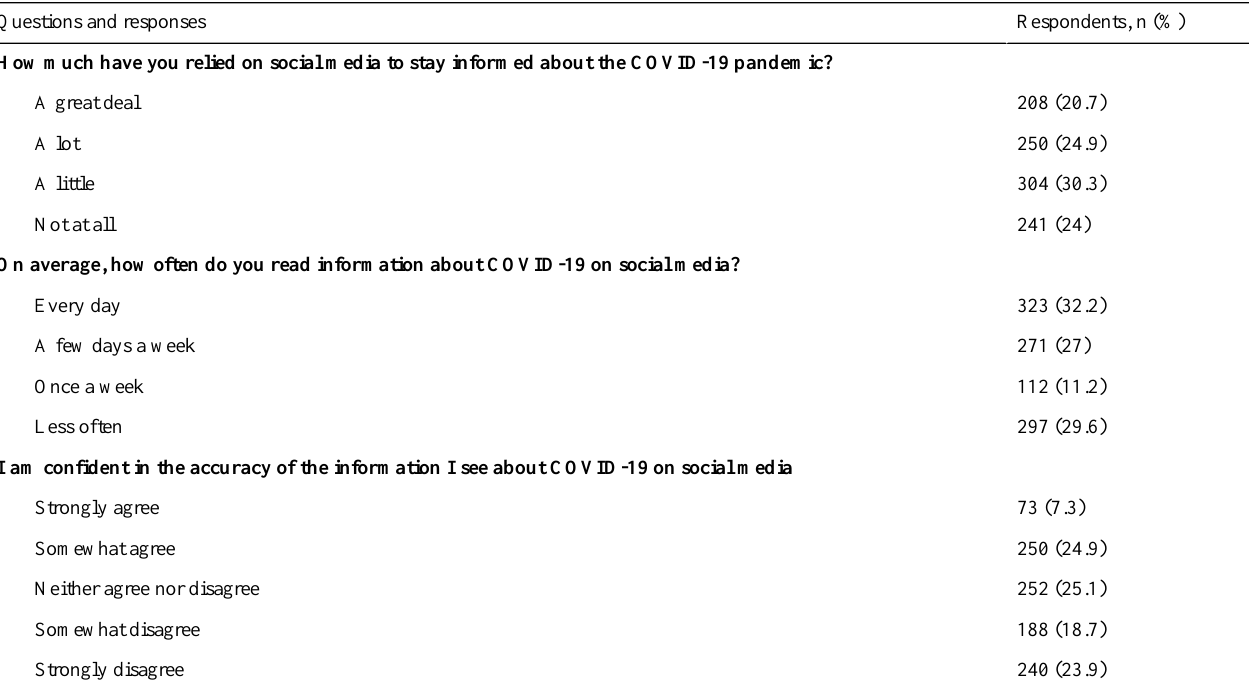
Table 2. Reliance on social media for pandemic-related information. a